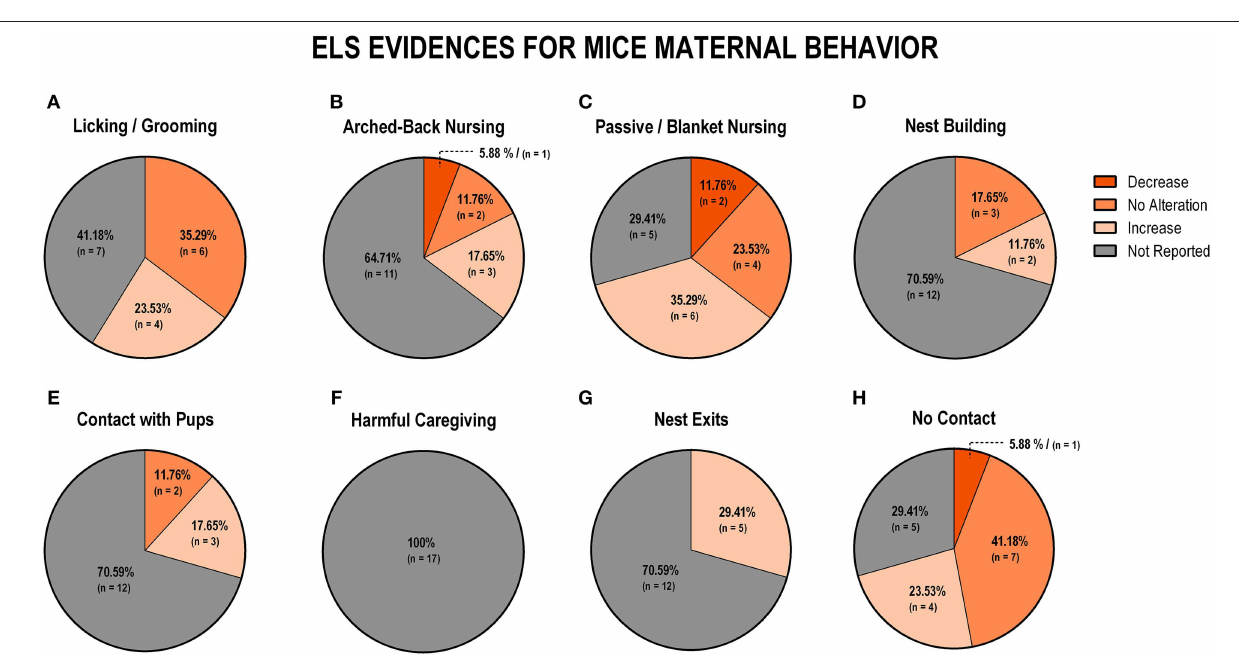
(43 protocols) of the 70 early life stress protocols included in this review. We identified 19 studies (38%) using MS and 11 (22%) using LB for rat studies, while MS was observed in 8 (40%)